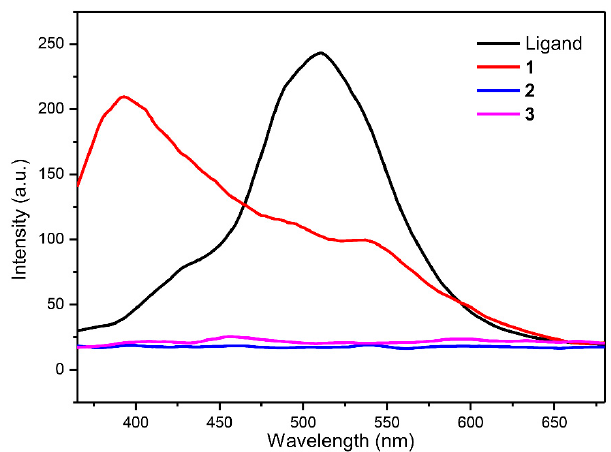
Figure 4. The solid-state photoluminescence properties of the ligand and complexes 1 – 3 at room temperature.